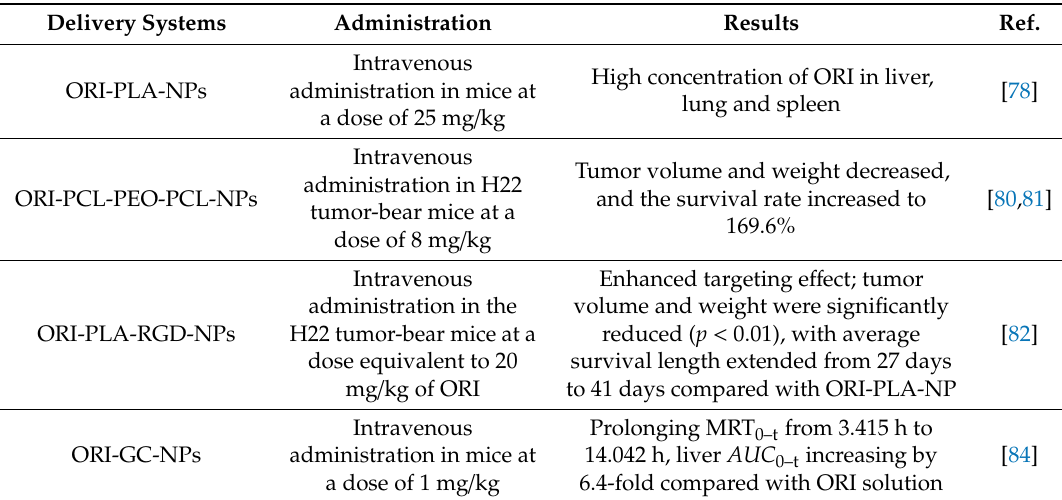
Figure 6. Schematic diagram of the preparation of ORI-Gal-PT-NPs. Table 3. Examples of different ORI polymer nanoparticles.